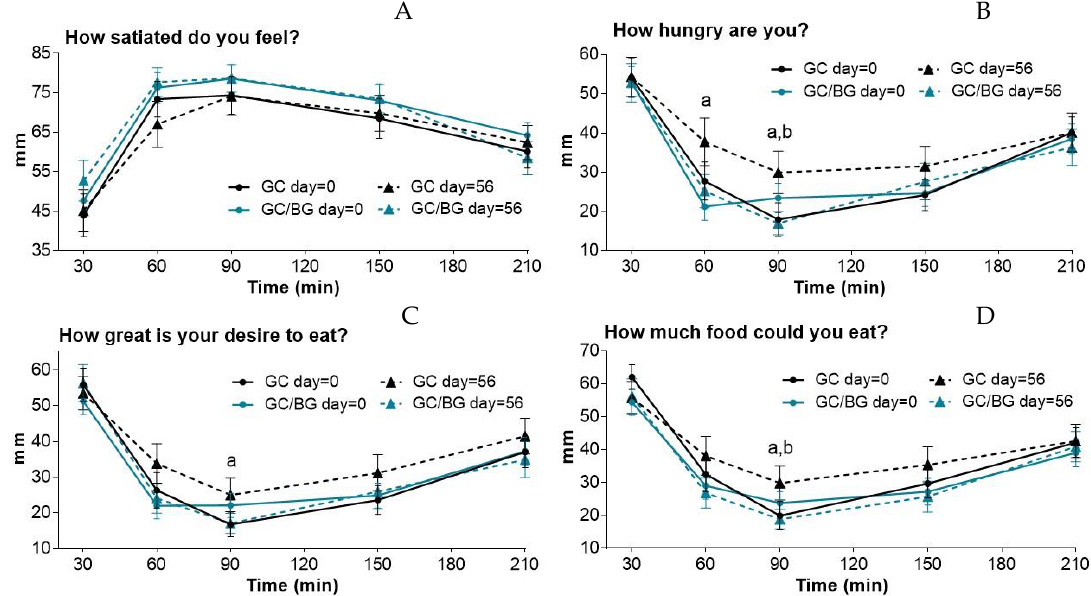
Figure 2. Variations of satiety and appetite sensations registered by the volunteers from 30 to 210 min after GC and GC/BG consumption on day = 0 and day = 56. Values correspond to the means ± SEM of scores ( n = 29) recorded by VAS. Significant differences according to Wilcoxon’s signed rank sum test: ( A ) no significant differences. ( B ) a p < 0.05 GC day = 0 compared with GC day = 56; b p < 0.05 GC day = 56 compared with GC/BG day = 56. ( C ) a p < 0.01 GC day = 0 compared with GC day = 56. ( D ) a p < 0.05 GC day = 0 compared with GC day = 56; b p < 0.05 GC day = 56 compared with GC/BG day = 56.